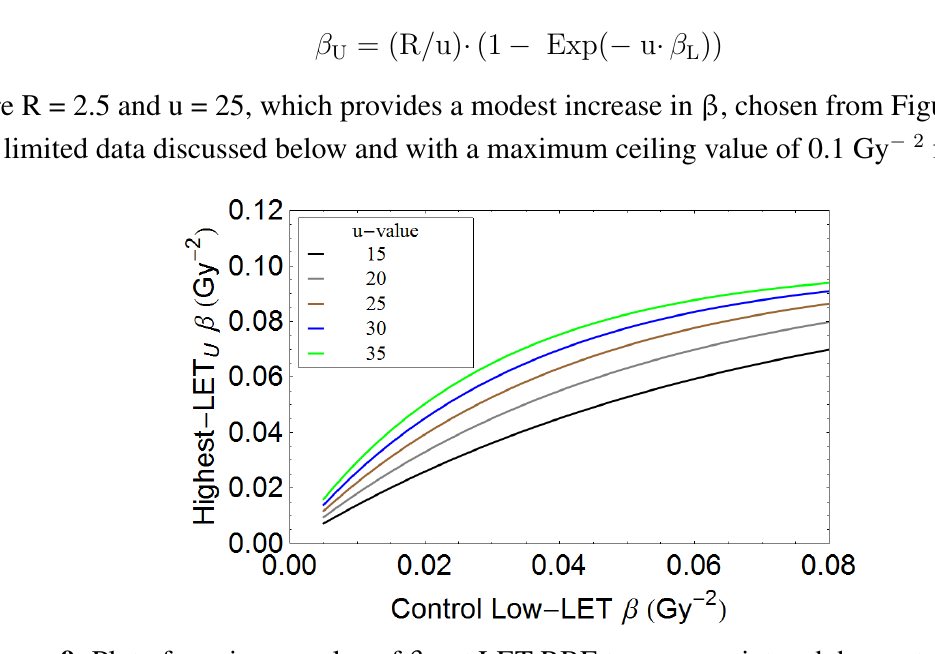
Figure A2. Plot of maximum value of β U at LET-RBE turnover point and the control low LET β parameter, for variation in parameter u.